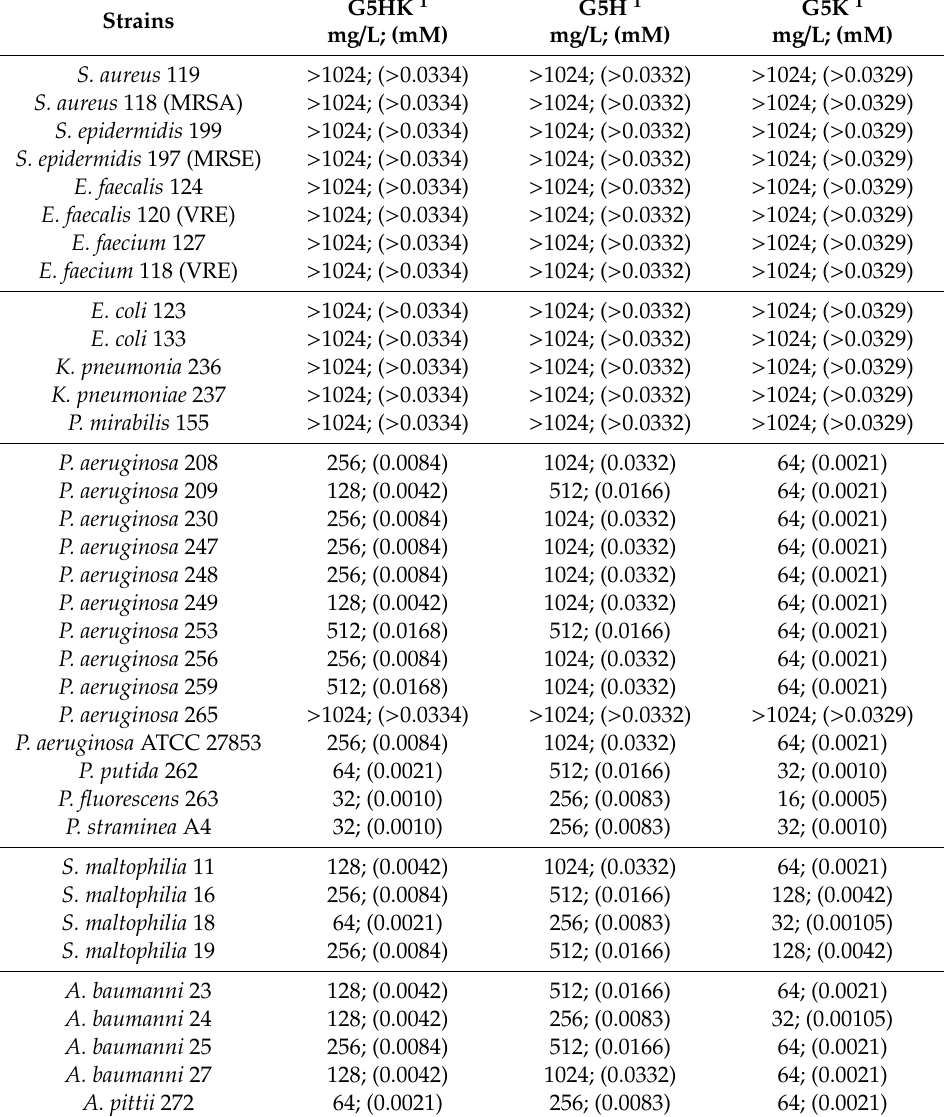
Table 1. MIC values of the three dendrimers, expressed as mg / L and millimolarity (mM), on the strains tested in the